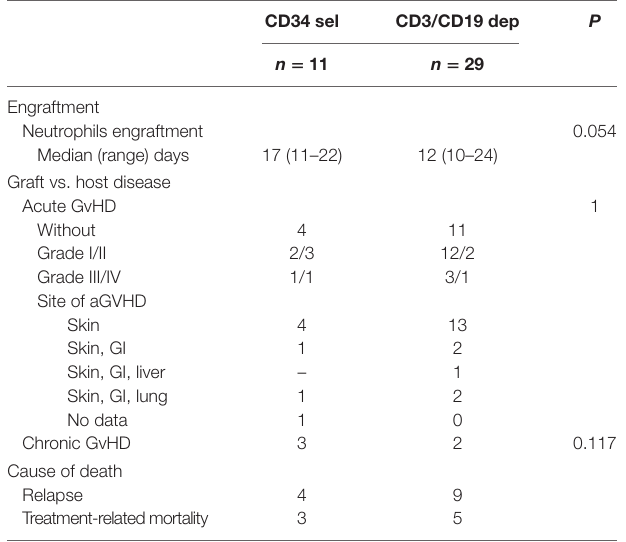
Table 4 | Clinical